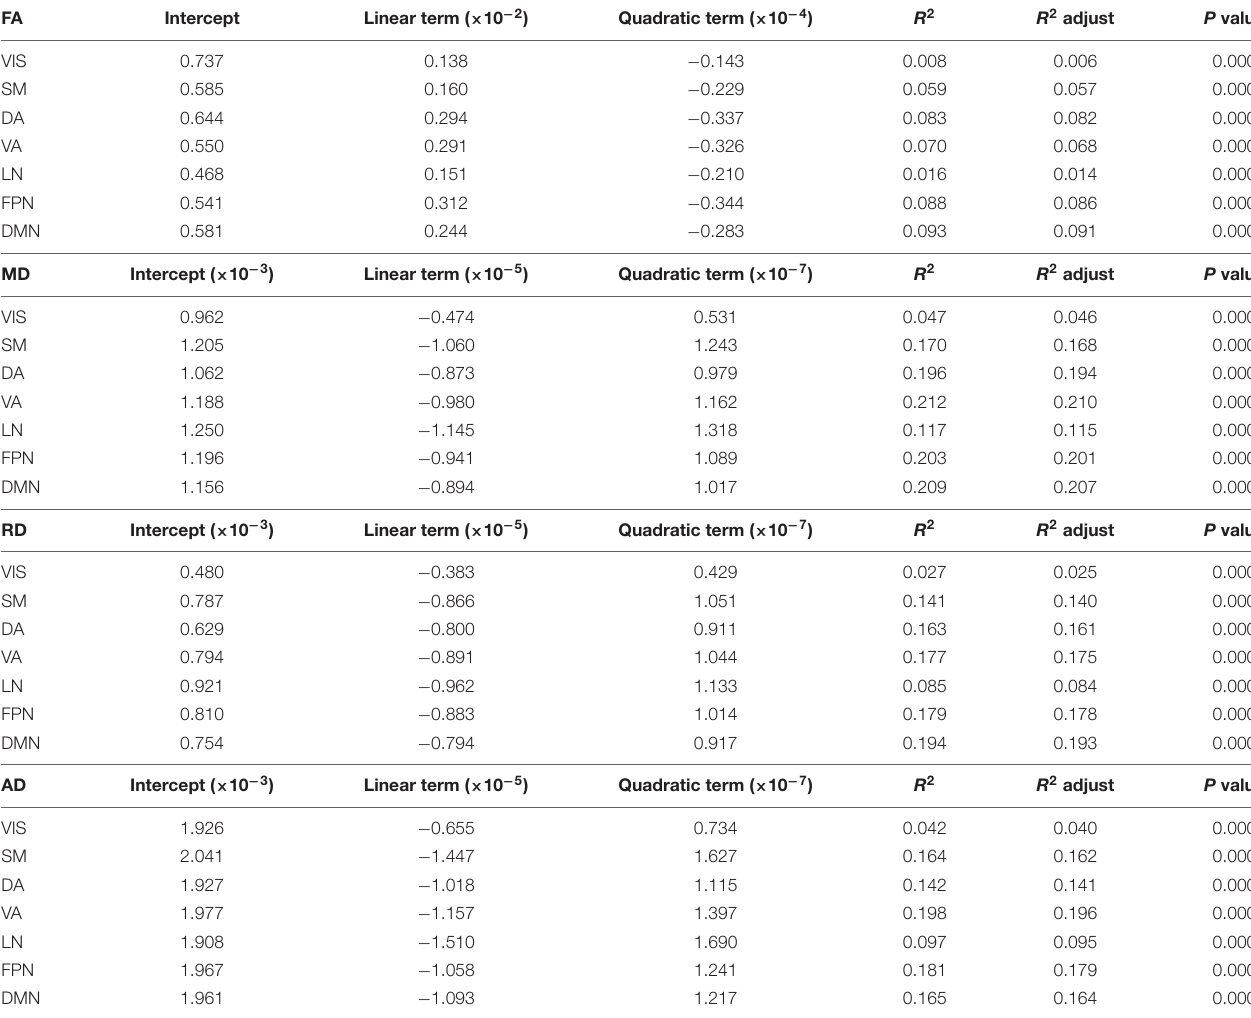
TABLE 2 | Fitting parameters for quadratic fit equations of each DTI parameter.